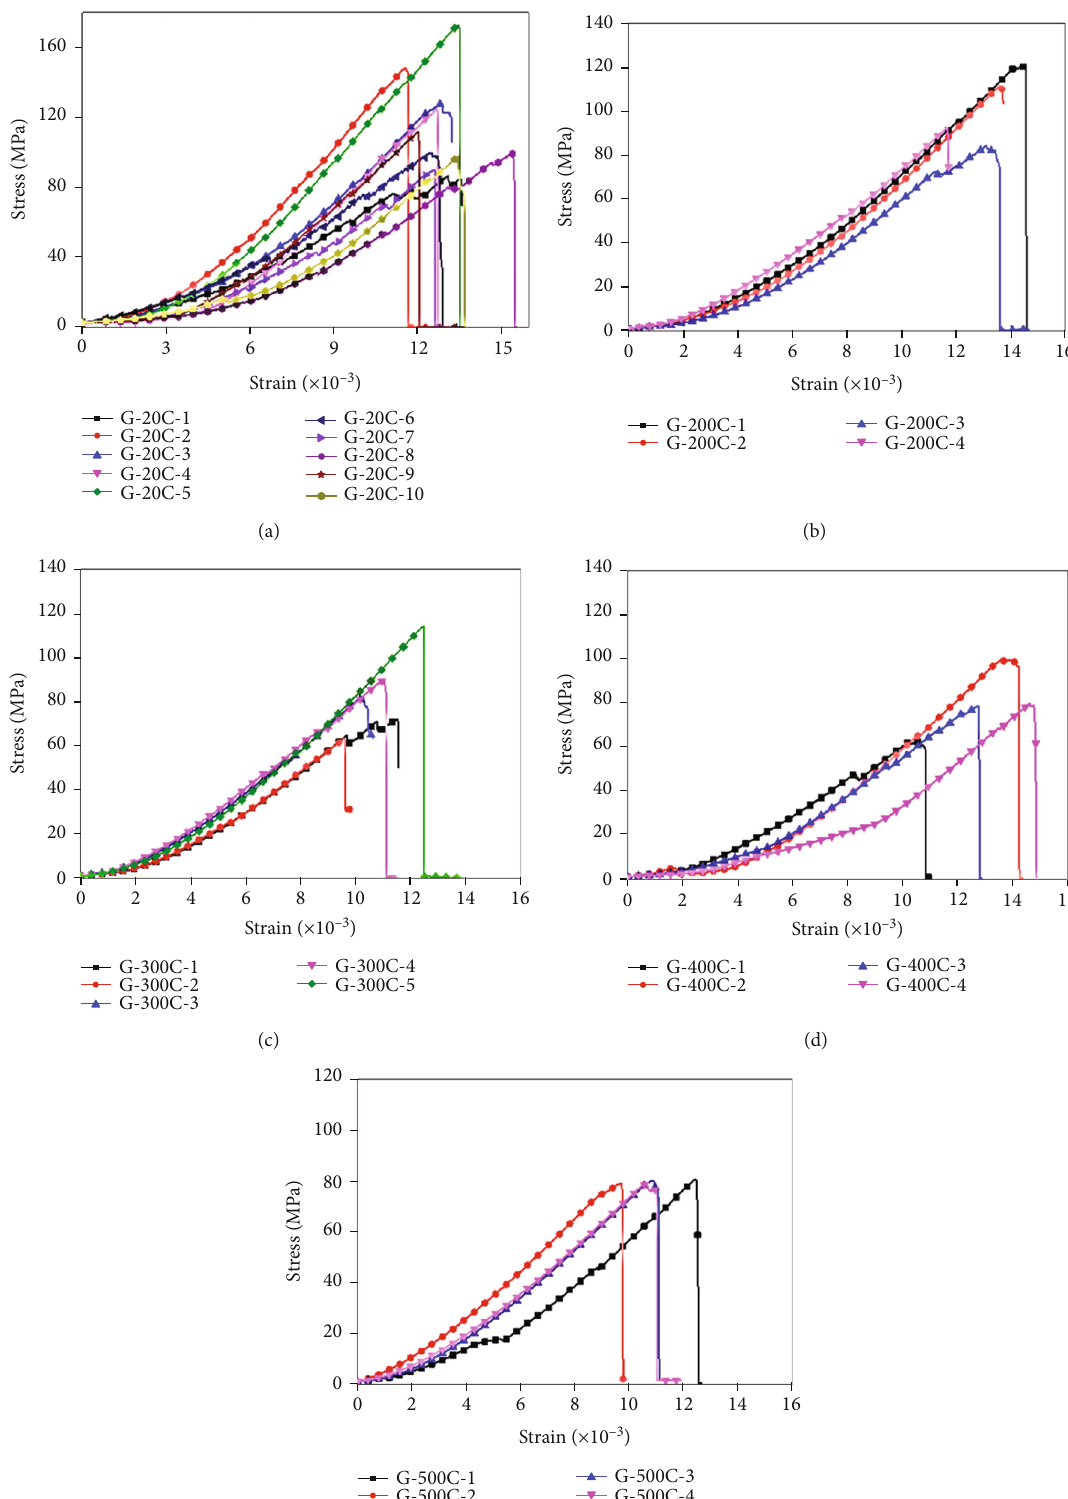
Figure 4: Uniaxial stress versus strain curves for granite at di ff erent temperatures. (a) room temperature ( ~ 20 ° C); (b) 200 ° C; (c) 300 ° C; (d) 400 ° C; (e) 500 °